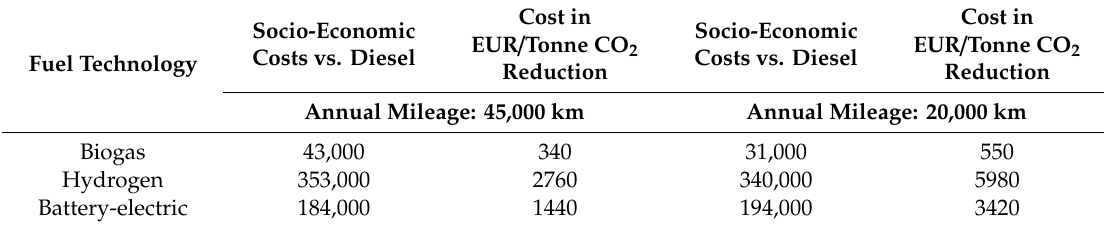
Table 7. Socio-economic costs per vehicle under a transition from light distribution trucks using diesel to other propulsion technologies. For annual mileages of 45,000 and 20,000 km respectively, assuming the scenario for today’s early phase of technological maturity. Figures in EUR,